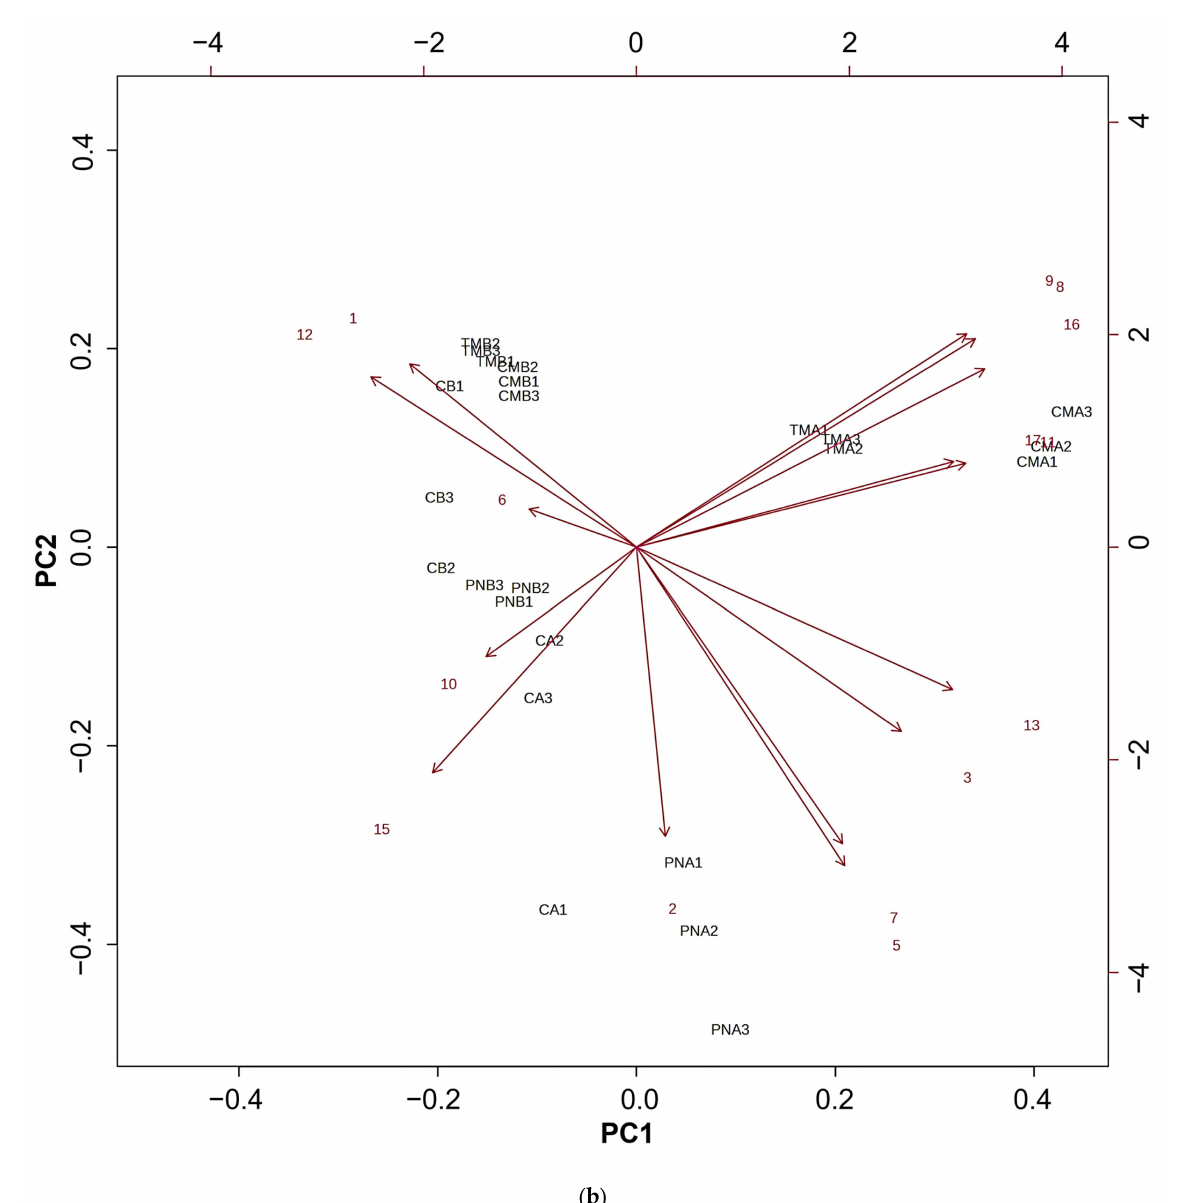
Figure 5. ( a ). PCA analysis of esters. ( A ): Score plot of ciders produced with different T. delbrueckii strains. PC1 accounts for 37% of the variability; PC2 accounts for 22.3% of the variability. ( B ): Score plot of ciders obtained with different methods: base cider (C), P é t-Nat (PN), Champenoise method (TM), Charmat method (CM). In sample label, letter A and B indicate ciders fermented by T. delbrueckii strain (A,B), respectively. ( b ). PCA analysis: biplot based on chemical analysis of esters: base cider (C), P é t-Nat (PN), Champenoise method (TM), Charmat method (CM). In sample label, letter A and B indicate ciders fermented by T. delbrueckii strain A and B, respectively. (1) Acetic acid ethylester; (2) propionic acid ethylester; (3) i-butyric acid ethylester; (4) 2-methylbutyric acid methylester; (5) butyric acid ethylester; (6) lactic acid ethylester; (7) 2-methylbutyric acid ethylester; (8) acetic acid 3-methylbutylester; (9) acetic acid 2-methylbutylester; (10) hexanoic acid ethylester; (11) acetic acid hexylester; (12) 2-hydroxy-4-methylvaleric acid ethylester; (13) succinic acid diethylester; (14) octanoic acid ethylester; (15) benzeneacetic acid ethylester; (16) acetic acid phenylethylester; and (17) decanoic acid